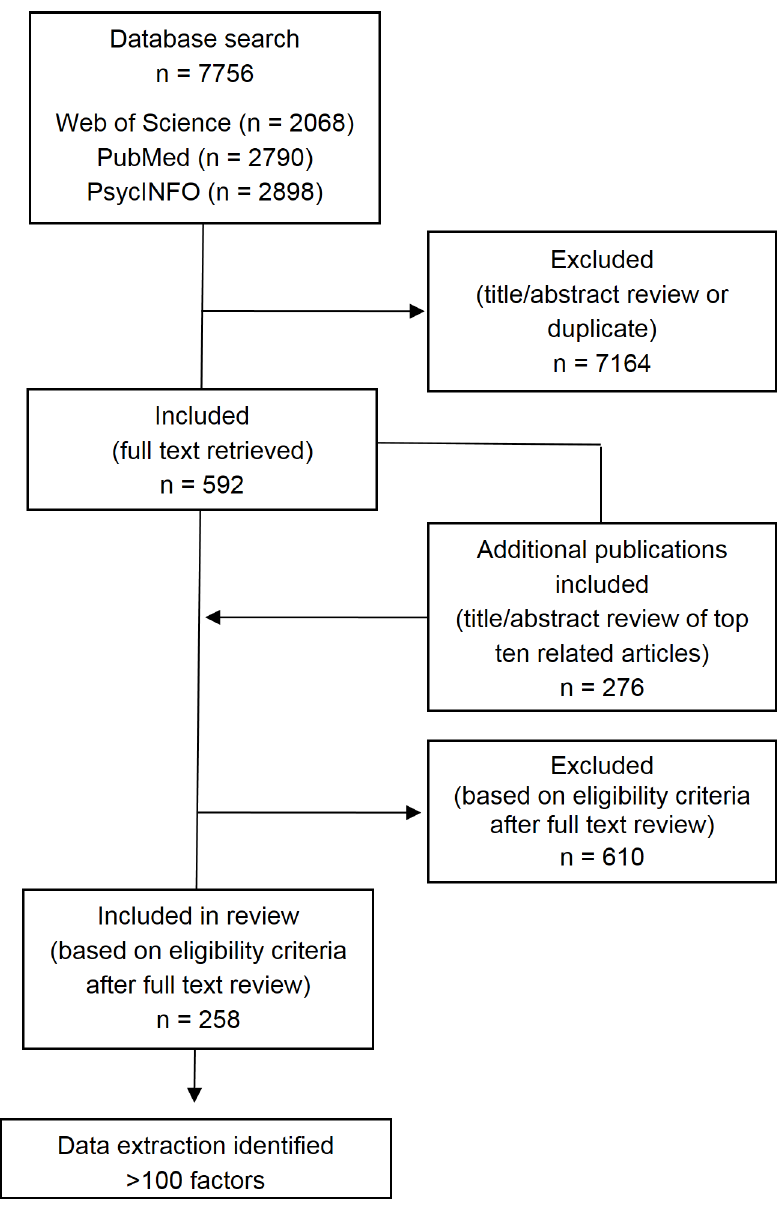
Fig 1. Flowchart of selection process for